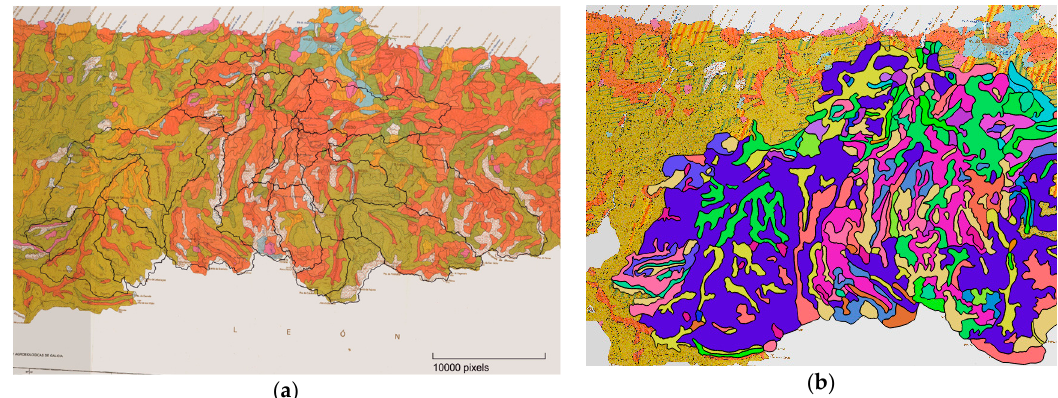
Figure 3. ( a ) referenced Soil map [4] and Nalon river basins; ( b ) Digitized Vector map of soils in Nalon